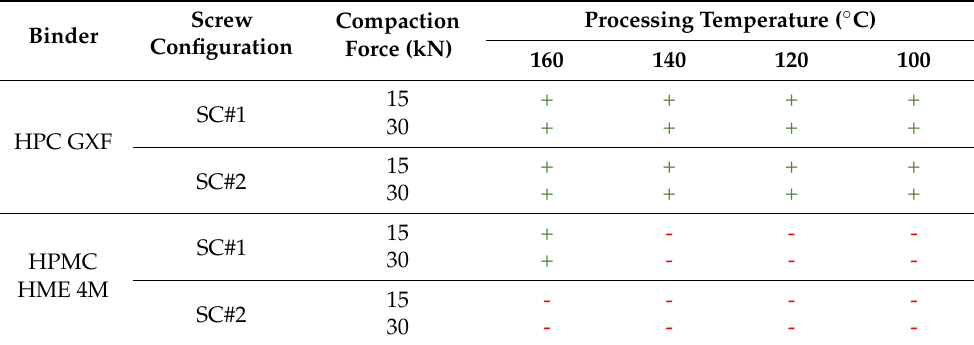
Table 4. Tablet compaction of milled samples. Tablets with acceptable hardness were obtained in the case of HPC GXF at all temperatures with screw configurations SC#1 and SC#2. In the case of HPMC HME 4M, intact tablets were obtained when the extrusion temperature was 160 ◦ C and with the high shear screw configuration